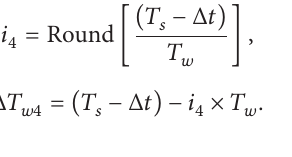
Figure 16: Three-phase load current response to DC sources disturbance.